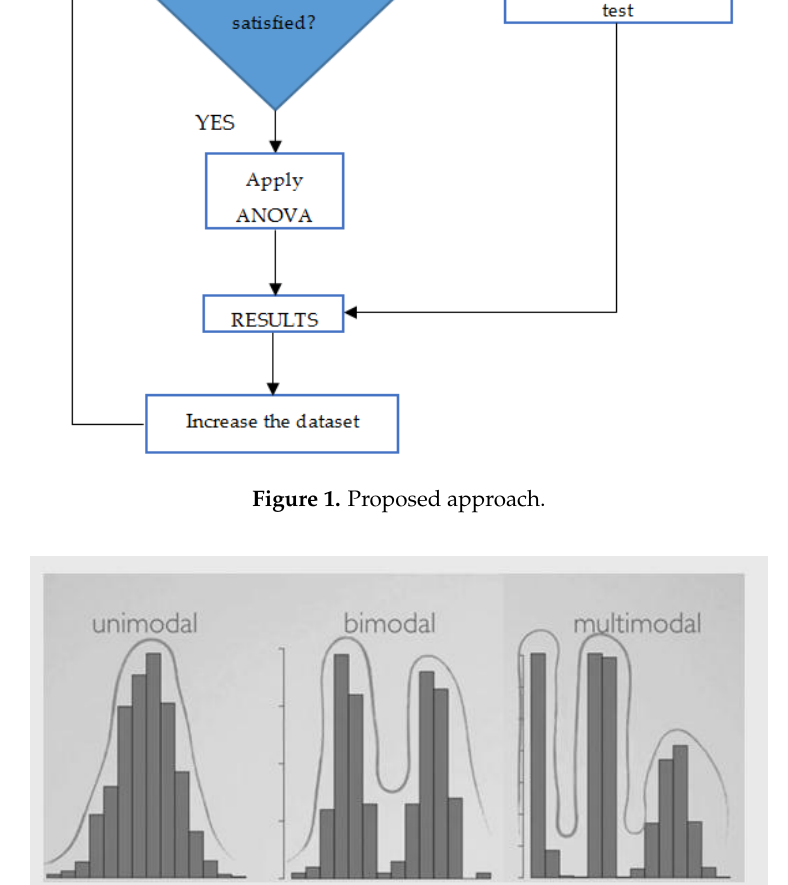
Figure 2. Different modality.